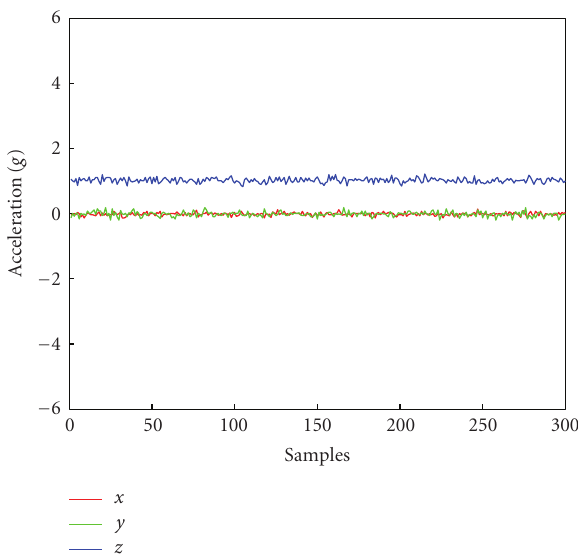
Figure 3: Nokia 5500 accelerometer data (phone at rest on a table).